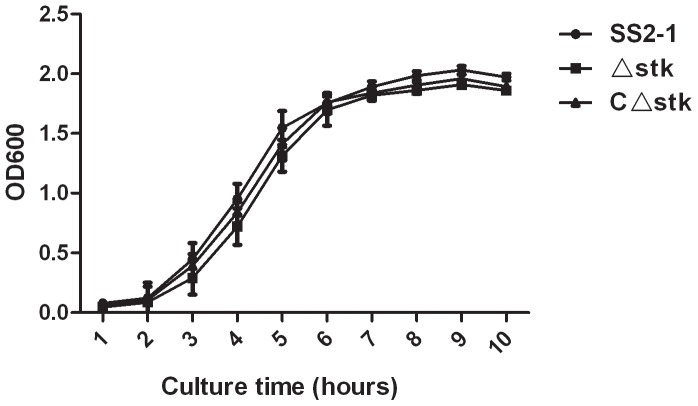
Growth characteristics of SS2-1, Δstk and CΔstk.Bacteria cell density is measured spectrometrically at 600